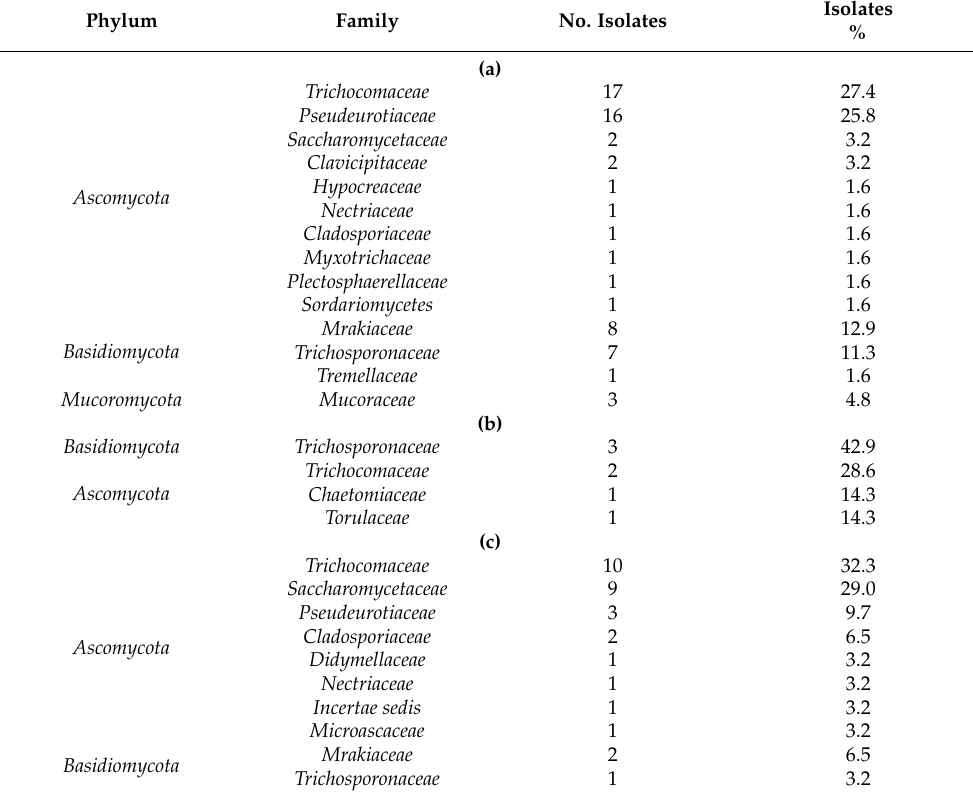
Table 1. Fungal diversity frequencies by phylum and family level of isolated from cave environmental samples at each cave: (a) Geum; (b) Eun; (c) Handemy. Trichocomaceae was most abundantly